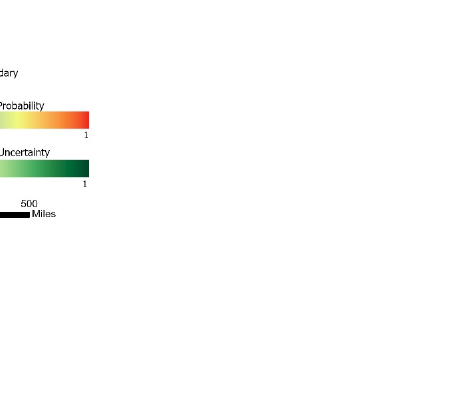
Figure 5. Partial dependency plots of covariates used in the RF model to estimate the spatial distri- bution of the mortality of the Barn Owl. The gray shading area indicates the confidence intervals derived from the model iterations. We report the mean decrease accuracy for each of the variables in the parentheses.